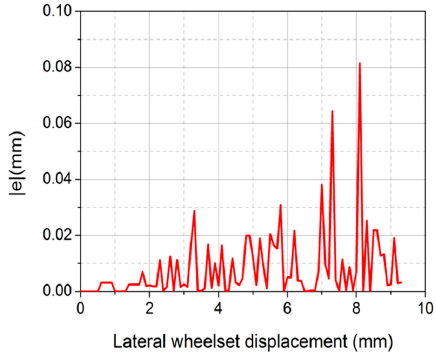
Figure 12. Reverse designed wheel profile and rolling radius difference. ( a ) Reverse designed wheel profile; ( b ) Comparison between rolling radius differences.